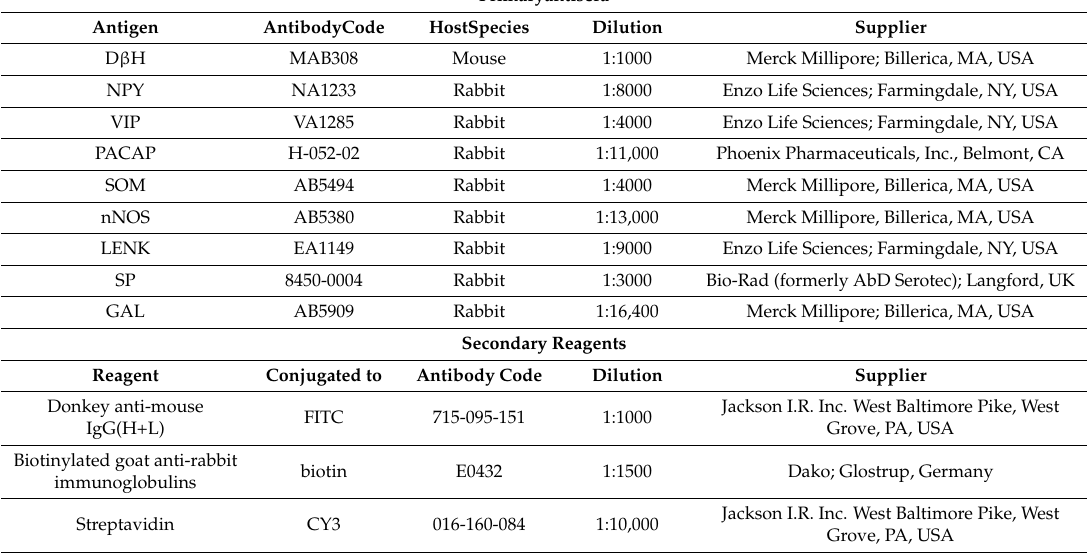
Primary antisera, secondary reagents and dilutions used in the study (D β H, dopamine- β -hydroxylase; NPY, neuropeptide Y; VIP, vasoactive intestinal polypeptide; PACAP, pituitary adenylate cyclase-activating polypeptide, SOM, somatostatin; nNOS, neuronal nitric